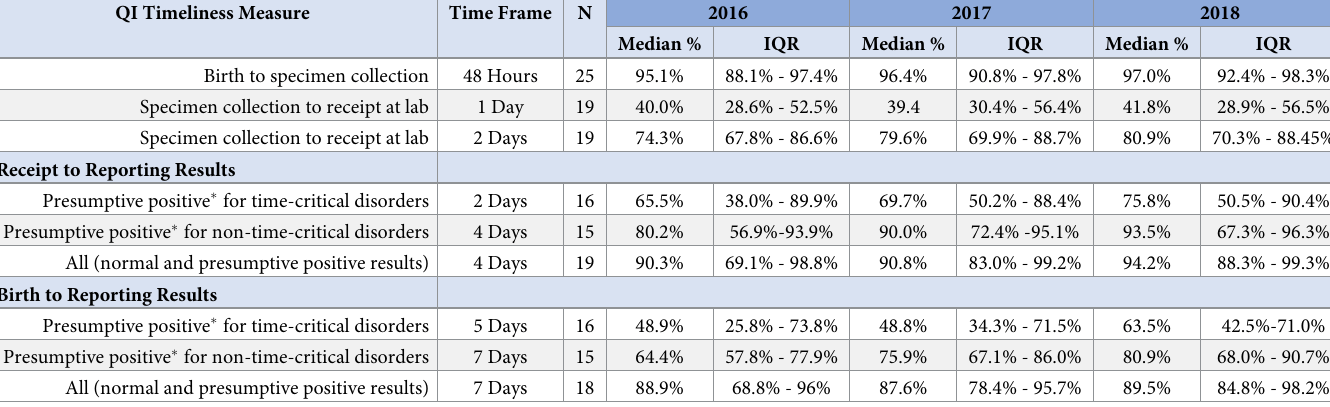
Table 5. Percent of newborn screening dried blood spot specimens from each program that met the timeliness goals, by year; medians of the programs’ results are reported; N is the number of programs that provided data for the specified quality indicator. For example: in 2016, half of the programs reported that at least 95.1% of the specimens met the goal of birth to specimen collection.